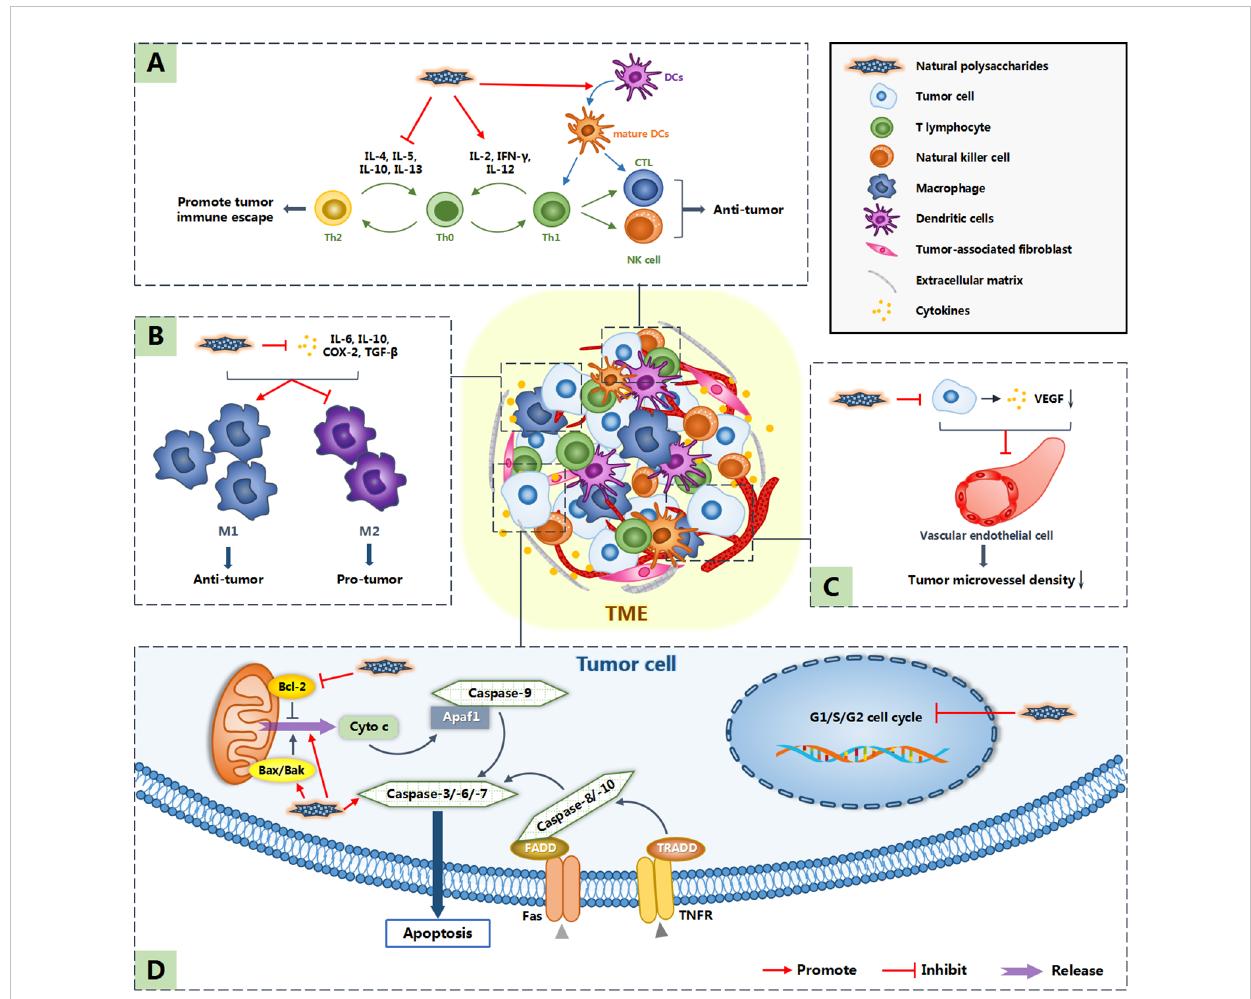
FIGURE 1 Anti-tumor mechanism of natural polysaccharides. Polysaccharides not only induce apoptosis by directly acting on tumor cells, but also inhibit the occurrence and development of tumors by acting on tumor microenvironment (TME). Among them, (A) indicates that natural polysaccharides promote the expression of cytokines such as IL-2, IFN- g and IL-12, inhibit the expression of cytokines such as IL-4, IL-5, IL-10 and IL-13, resluting in promoting the differentiation of Th0 cells into Th1 cells, which have anti-tumor effect. What ’ s more, natural polysaccharides activate DC cells, allowing them to function normally in antigen presentation. (B) indicates that polysaccharide reduces the concentration of cytokines such as IL-6, IL-10, COX-2 and TGF- b in TME, so as to promote the differentiation of M1 macrophages,which play an anti-tumor role. (C) indicates that polysaccharides down regulate the expression of VEGF and so inhibit tumor related angiogenesis. (D) shows the direct anti-tumor effect of natural polysaccharides: cell cycle arrest and inducing